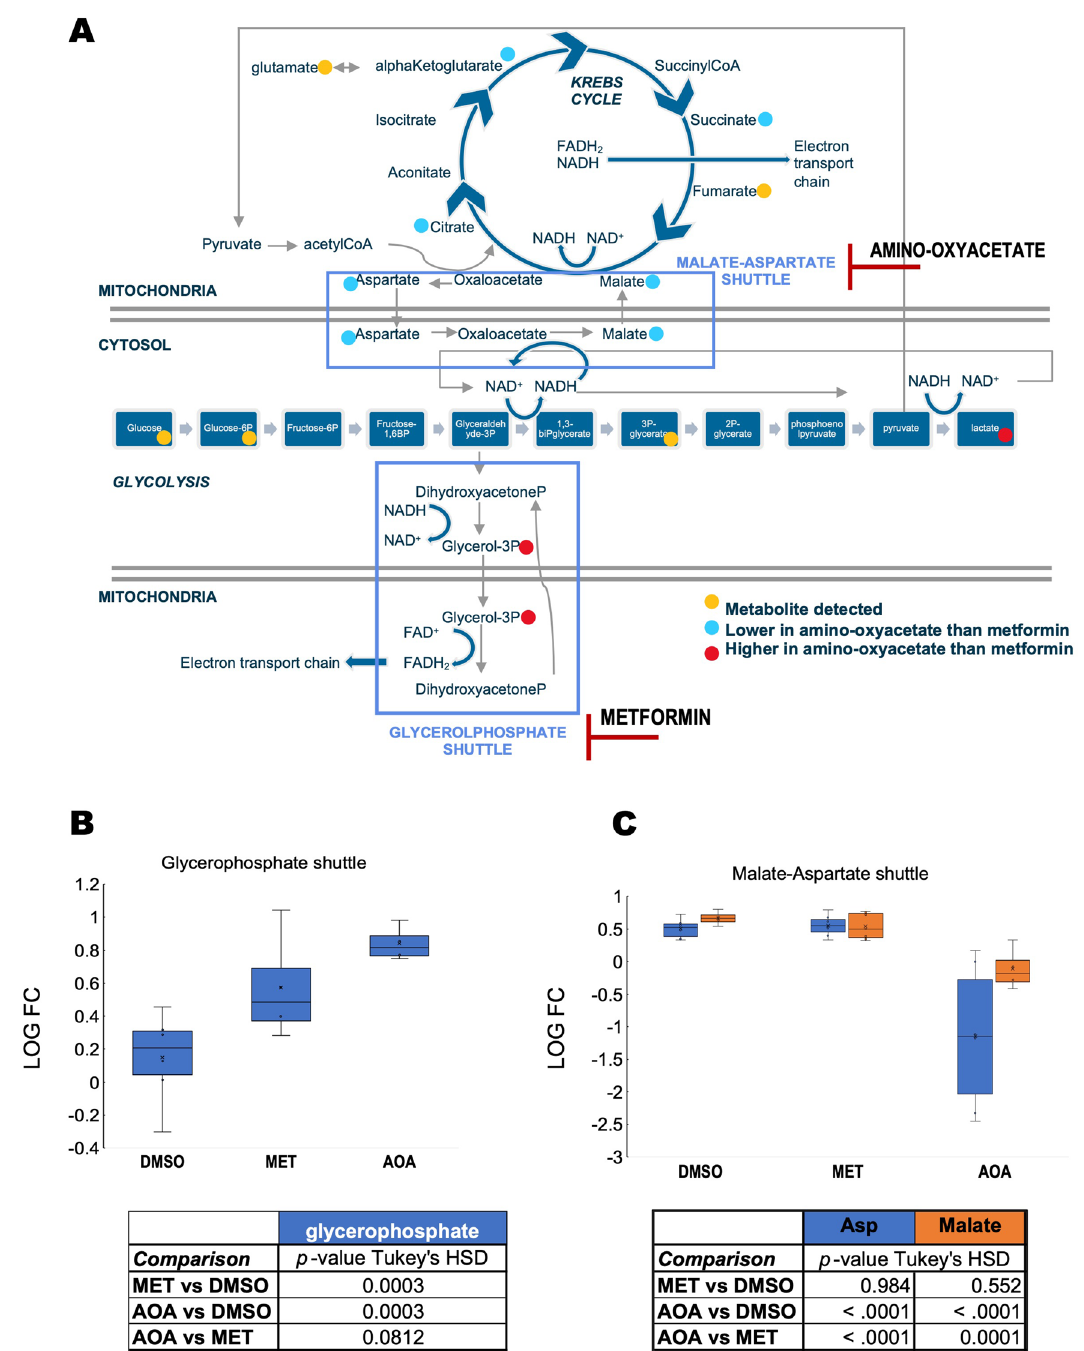
Figure 6. Metformin-dependent inhibition of glycerophosphate shuttle and amino-oxyacetate inhibits the malate- aspartate shuttle in fibroblasts from FXTAS carriers with high mitochondrial glycerol-3-phosphate dehydrogenase activity. Four primary fibroblasts (50 µM metformin or MET, 5 mM amino-oxyacetate or AOA) were treated for 24 h. Their metabolome and mitochondrial bioenergetic capacity were compared to DMSO-treated as indicated in the “Methods”. Panel ( A ): Inhibition sites for metformin and amino-oxyacetate. The inhibition exerted by these compounds is shown in the context of glycolysis, Krebs’ cycle, and malate-aspartate and glycerophosphate shuttles. Panel ( B ): Levels of glycerol-3-phosphate were evaluated by metabolomics under each condition (vehicle or dimethylsulfoxide, DMSO; MET metformin; AOA amino-oxyacetate) as a proxy for glycerophosphate shuttle. Panel ( C ): Malate-aspartate shuttle components (Aspartate or Asp in blue; malate in orange). For panels ( B , C ): Data were visualized by using a box plot (box height is the interquartile range; top and bottom of boxes are the upper and lower quartiles; top and bottom lines represent the maximum and minimum values; median is shown as a line; average as an x). Tables at the bottom of each panel show the p -values obtained from Tukey’s honestly significant difference (HSD) for each comparison and show only outcomes with p -values ≤ 0.1. Matched-samples ANOVA was run to test for statistical significance across treatments followed; if p ≤ 0.05, a Tukey’s HSD post-test was run. All analyses were performed with